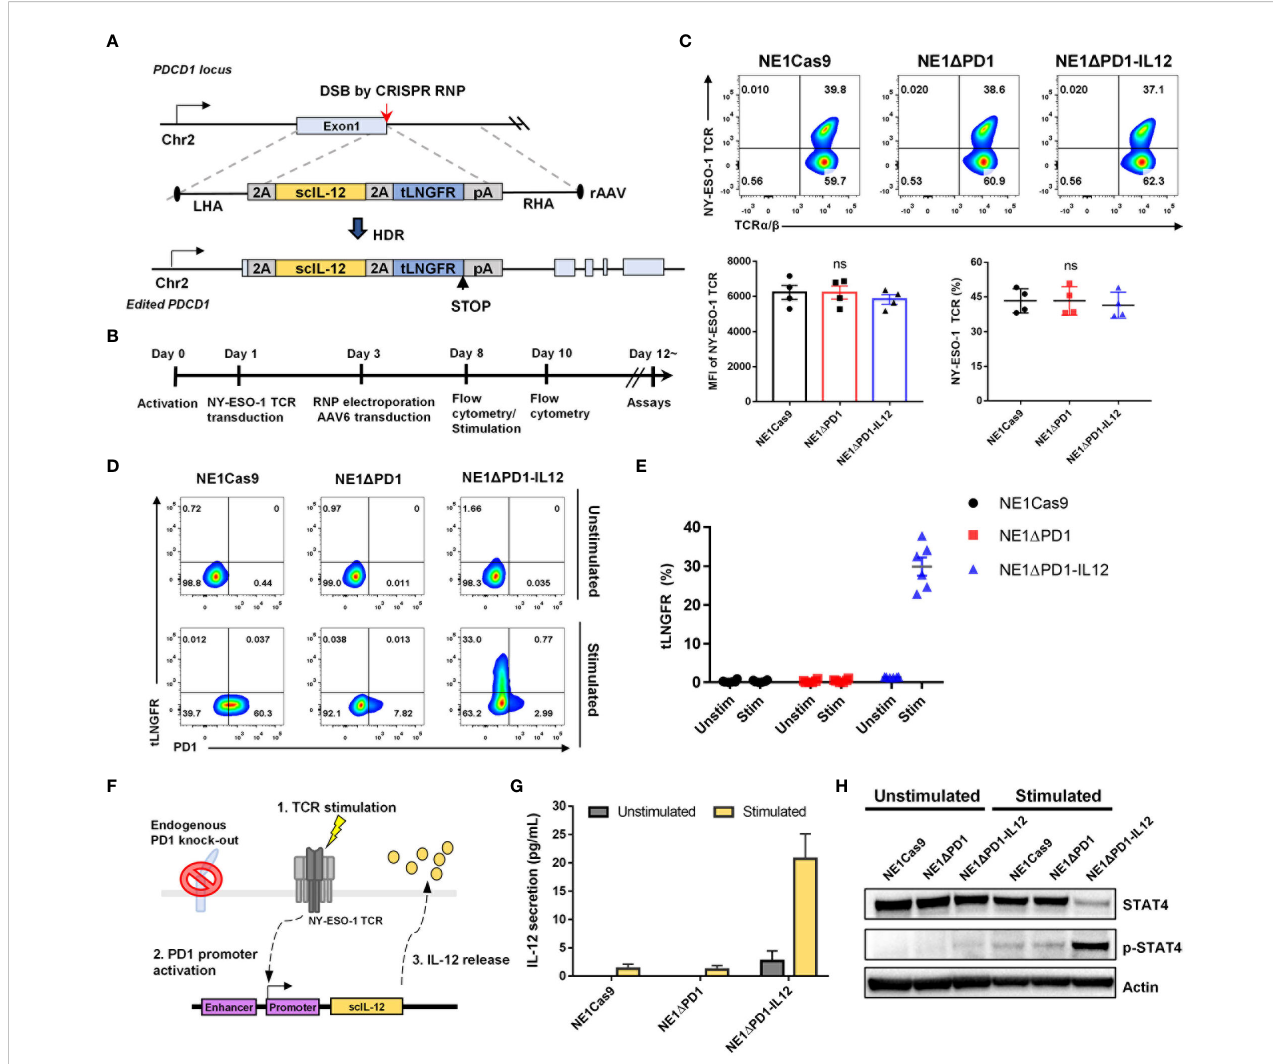
FIGURE 1 CRISPR-mediated PDCD1 locus editing to generate D PD-1-IL-12-NY-ESO-1-speci fi c T cells. (A) Schematic diagram for the targeted insertion of IL-12 into the PDCD1 locus using CRISPR RNP and AAV6 delivery (LHA and RHA: left and right homology arms, respectively, 2A: self-cleaving peptide, 2tLNGFR: truncated low-af fi nity nerve growth factor receptor, pA: polyA signal). (B) Timeline for the consecutive lentiviral transduction, electroporation, and AAV6 transduction to generate D PD-1-IL-12-edited NY-ESO-1-engineered T cells. (C) Five days after electroporation, the surface expression levels of NY-ESO-1 TCR on engineered T cells were analyzed using fl ow cytometry and the percentage and mean fl uorescent intensity (MFI) of NY-ESO-1 TCR were quanti fi ed (n = 4; four independent experiments with four donors). Data were analyzed using one-way ANOVA. ns, not signi fi cant. (D) Representative fl ow cytometry plot of PD-1 and tLNGFR upregulation in engineered T cells two days after stimulation with a CD3 and a CD28. (E) Percentage of tLNGFR in engineered T cells before and after stimulation. Data are presented as the mean ± SEM (n = 6; six independent donors). (F) Schematic diagram of the stimulation-dependent release of targeted IL-12 from the edited PDCD1 locus. (G) After T cells were stimulated with A375 cells for 2 days, the amount of IL-12 secreted into the culture supernatant was measured using a CBA assay. Data are presented as the mean ± SEM (n = 3; three independent experiments with three donors). (H) Representative western blot image showing Tyr 693 phosphorylation of STAT-4 in NYESO1- D PD-1-IL-12 T cells before and after stimulation with a CD3 for 3 days (n = 3; three